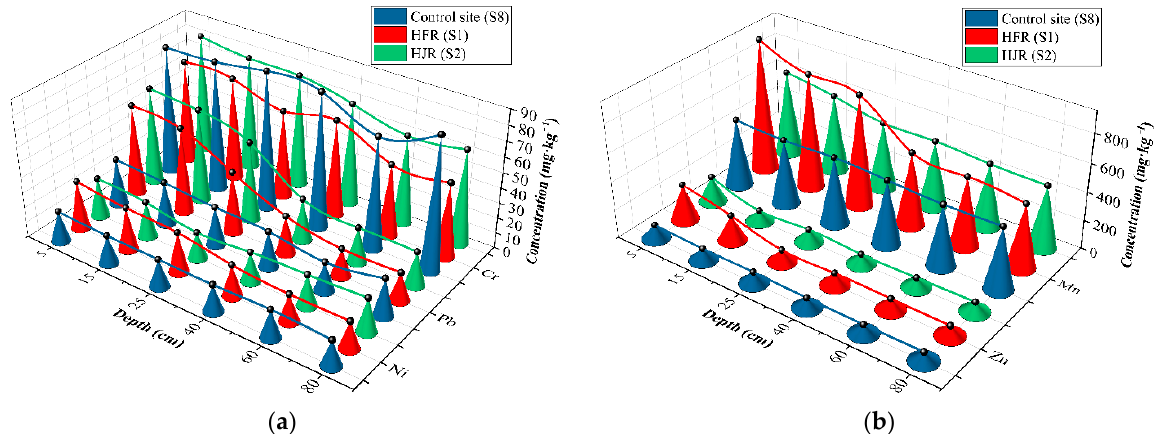
Figure 2. Concentrations of heavy metals in the soil profile (Ni, Pb, and Cr ( a ); Zn and Mn ( b